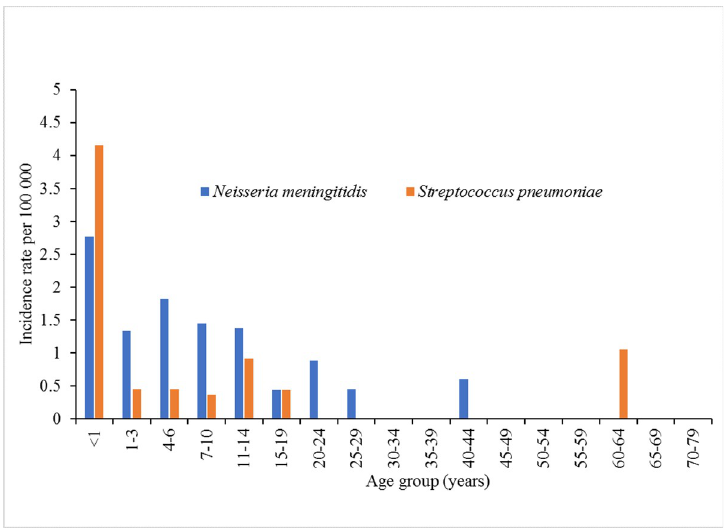
Fig 2. Incidence rates of meningococcal and pneumococcal EM by age group. Children < 1-year-old had the highest IRs for bacterial EM; 4.2 and 2.8 per 100,000 children for pneumococcal and meningococcal EM, respectively. The IR of pneumococcal EM among children < 1 yr. of age was 8 times higher than the IR among children aged 1–14 years. No significant difference by age was observed for meningococcal EM.